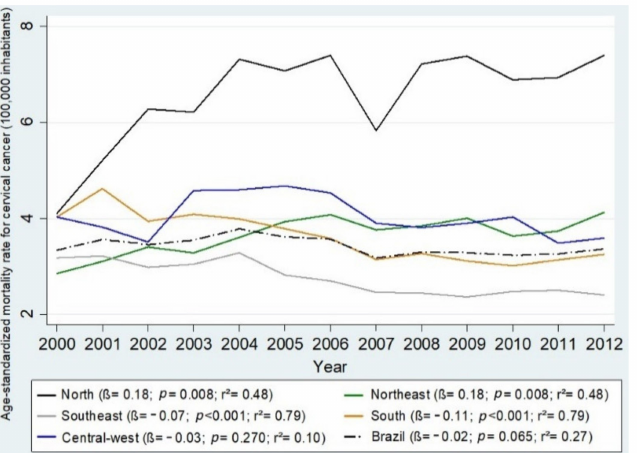
Figure 4. Mortality rate for cervical cancer (100,000 inhabitants), resident in Brazil aged 25–64 years, in the period from 2000 to 2012 and estimates obtained from linear regression, according to year and